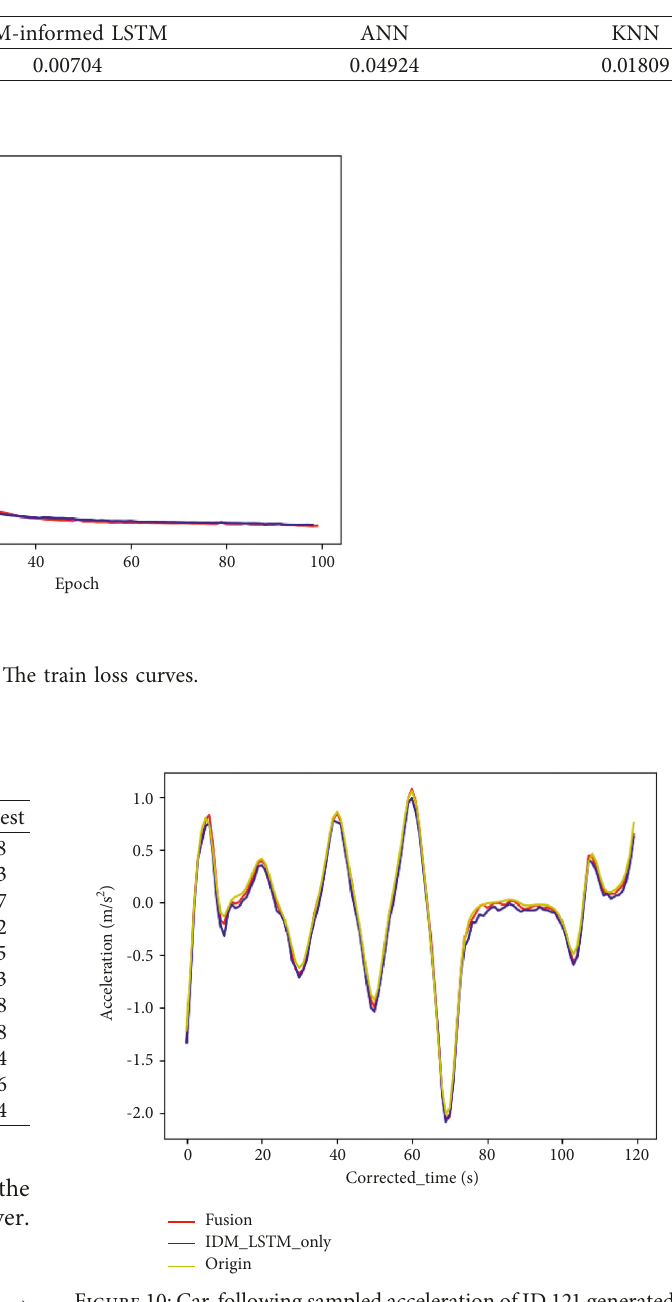
Table 6: The results of different models.